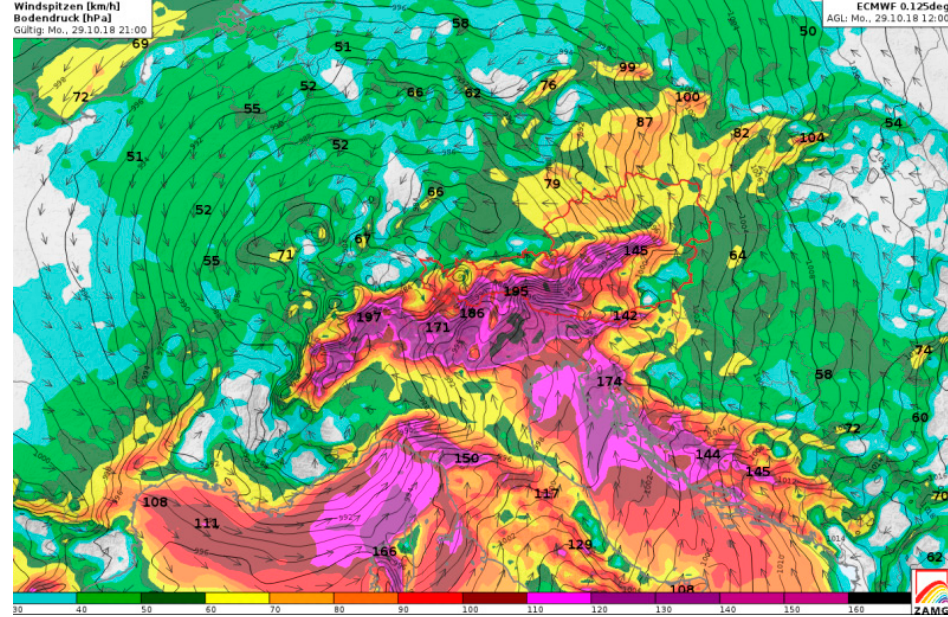
Figure 2. Synoptic chart for storm Vaia on 29 October 2018 (ECWMF, European Centre for Medium ‐ Range Weather Forecasts).